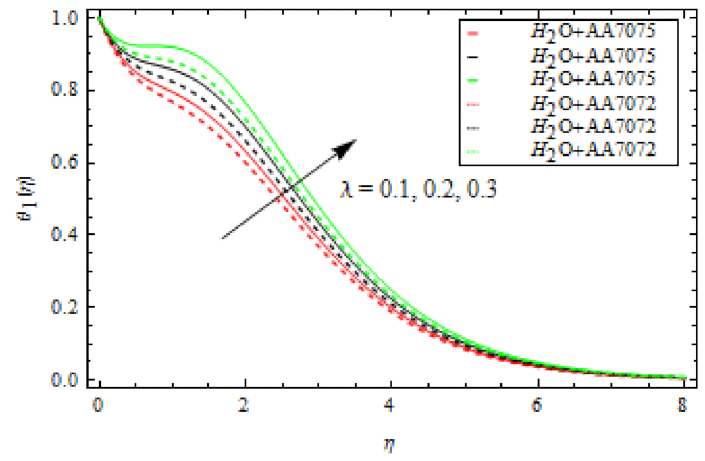
Figure 10. Influence of viscous dissipation parameter λ on temperature profile.